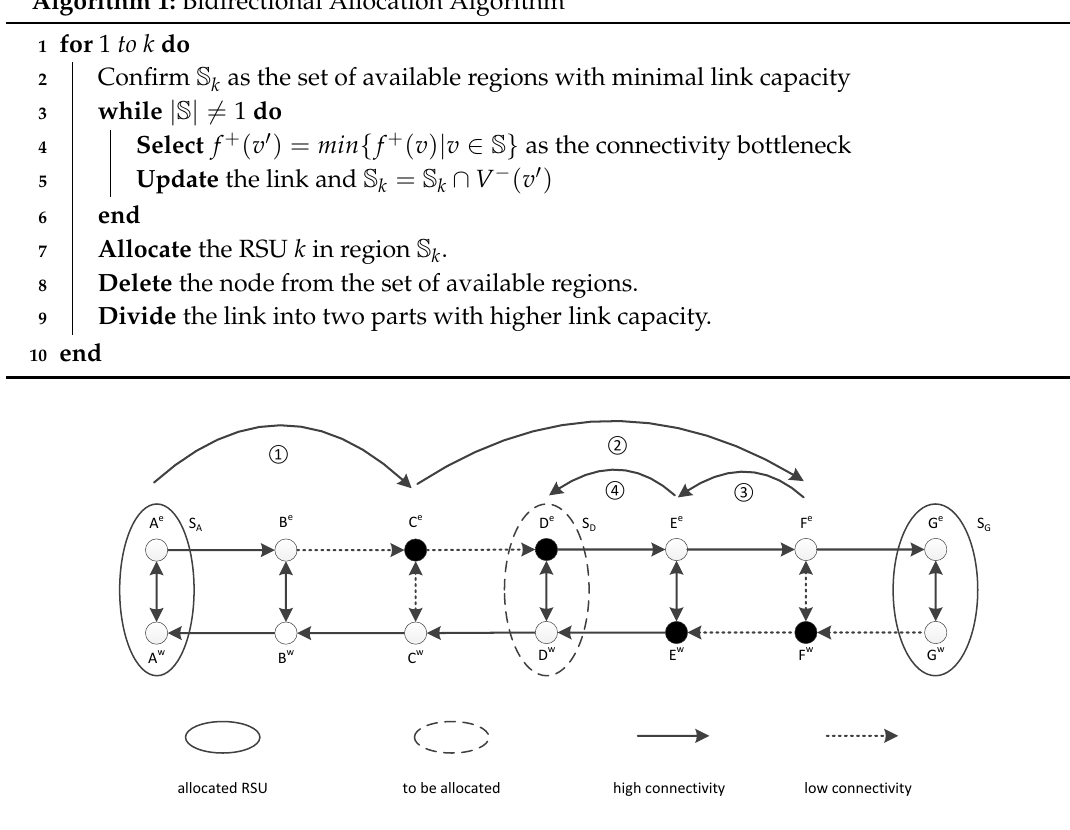
Figure 4. Ladder graph for bidirectional traffic